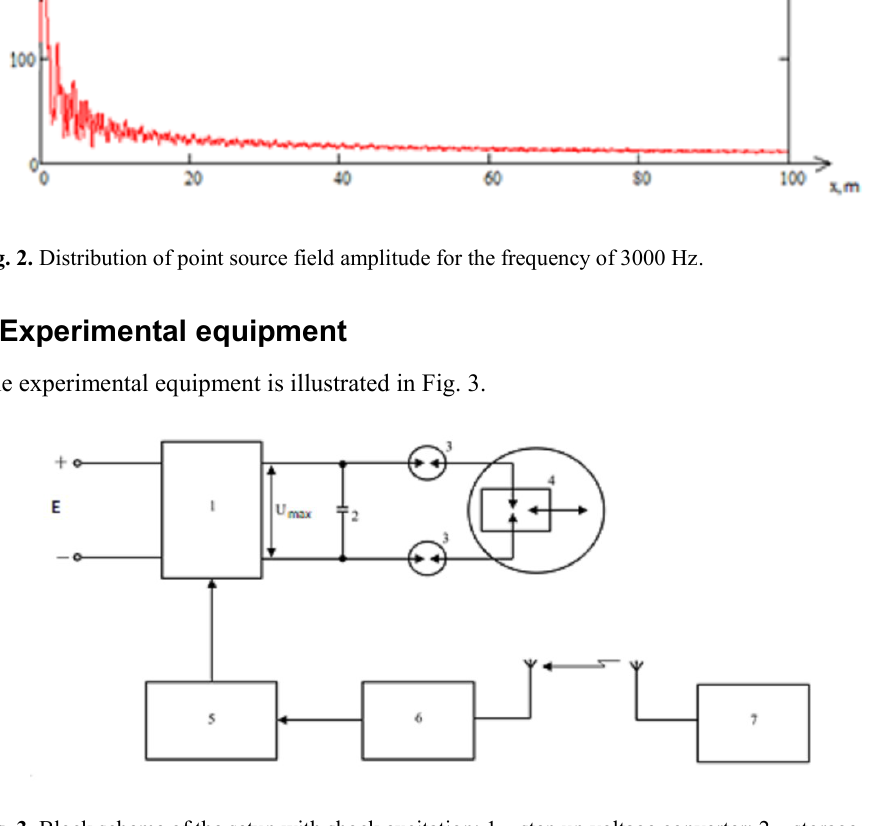
Fig. 3. Block scheme of the setup with shock excitation: 1 – step up voltage converter; 2 – storage capacitor; 3 – high-voltage dischargers; 4 – hydroacoustic radiator; 5 – control system; 6 – Bluetooth- module; 7 – control signal